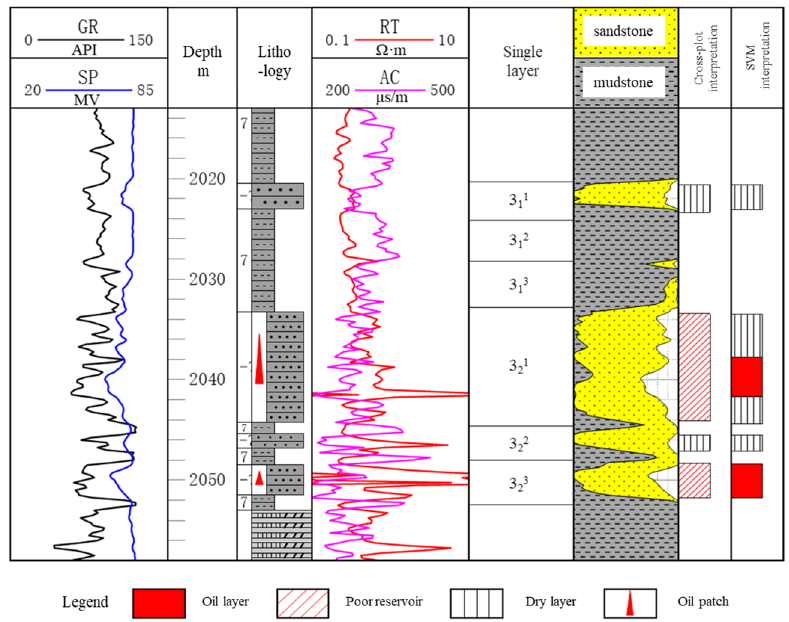
Figure 8. Identification of thin oil layer of well G9-14-4 .